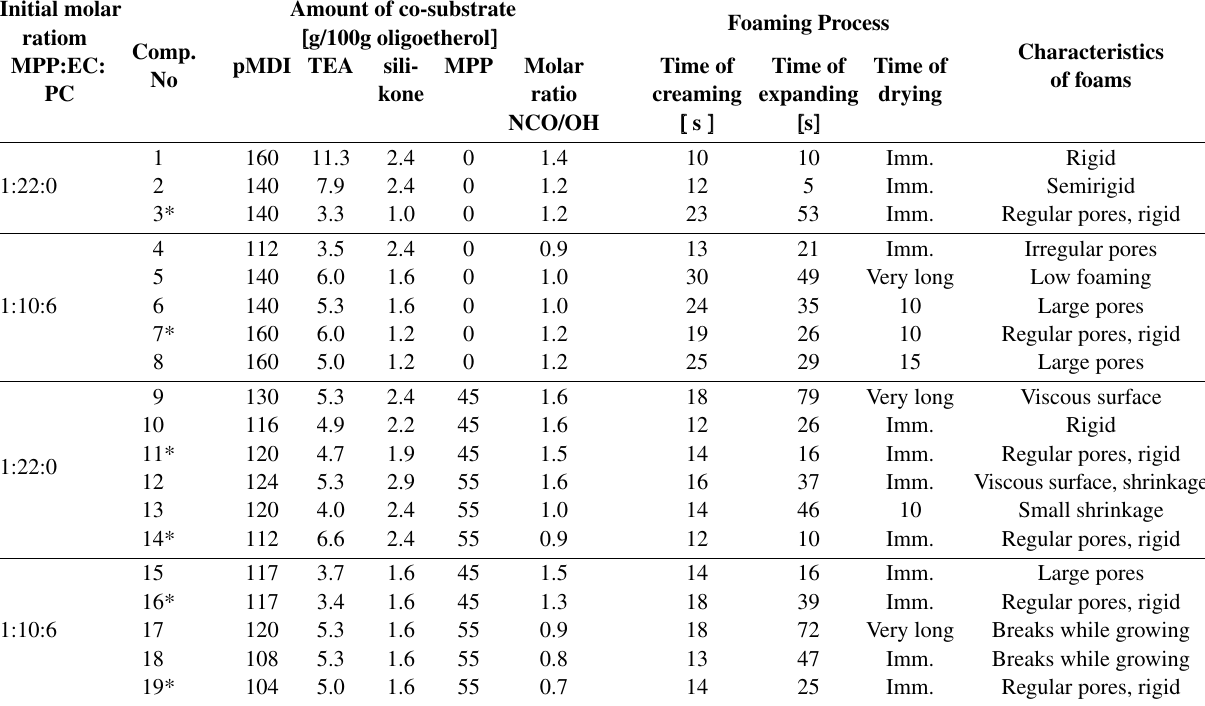
Foaming Process